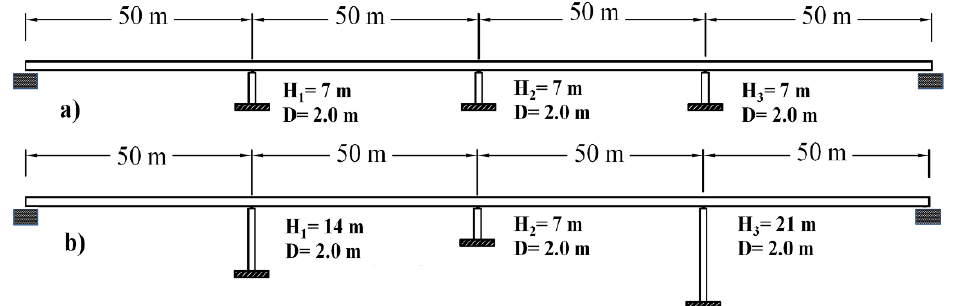
Figure 1. Bridges’ properties: ( a ) regular bridge; ( b ) irregular bridge. All column diameters, D, were 2.0 m. For the case of the regular bridge, all